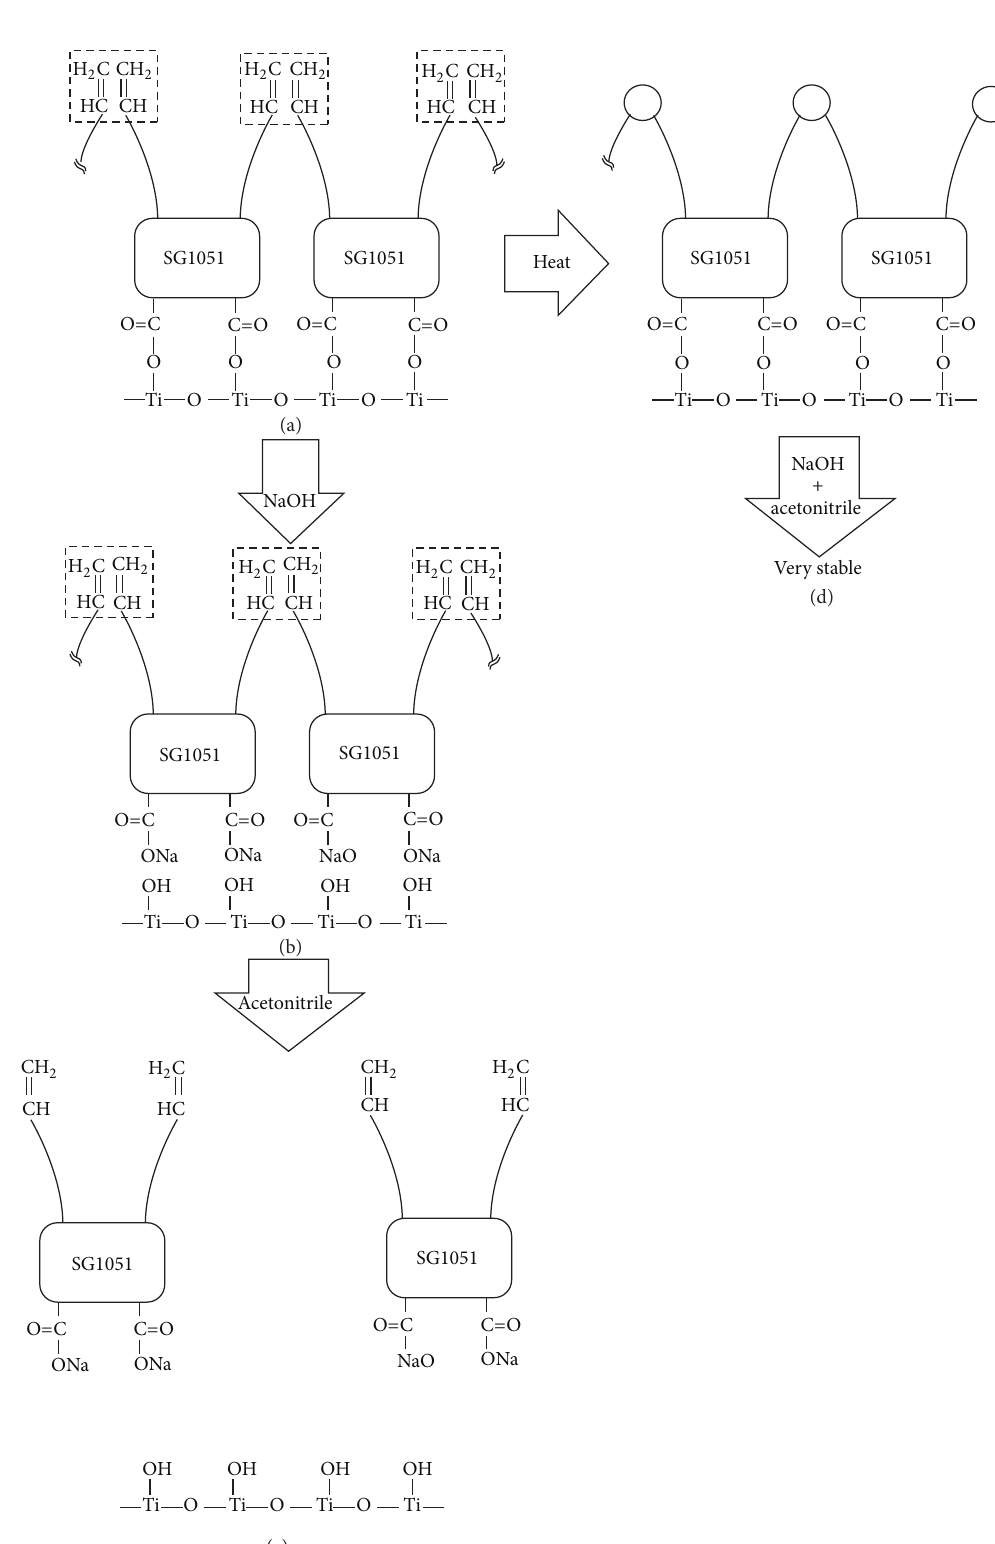
Figure 3: Images of double-bond-edged Ru dye on TiO 2 surface. The squares by broken line suggest 𝜋 - 𝜋 stacking